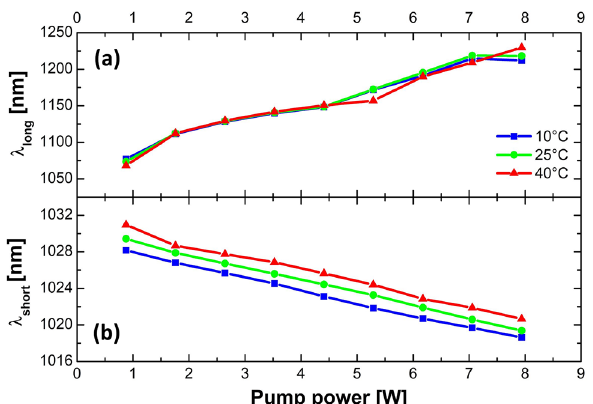
Figure 8. Location of spectral edges in the optical spectrum of amplified pulses in GMN regime, where the intensity equals 1/10 of the maximal intensity for three different temperatures of the cooling plate: ( a ) long- wavelength edge, ( b ) short-wavelength edge.